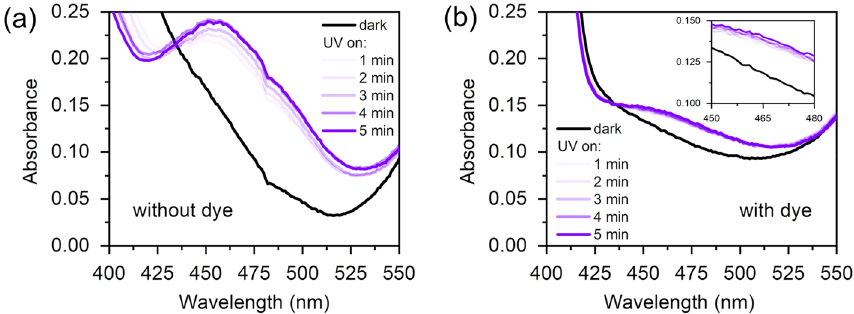
Figure 1. Absorption spectra of 6 μm thick LCN films without ( a ) and with dye ( b ) in dark and after UV illumination with 1–5 min duration. Power is ~ 50 mW/cm 2